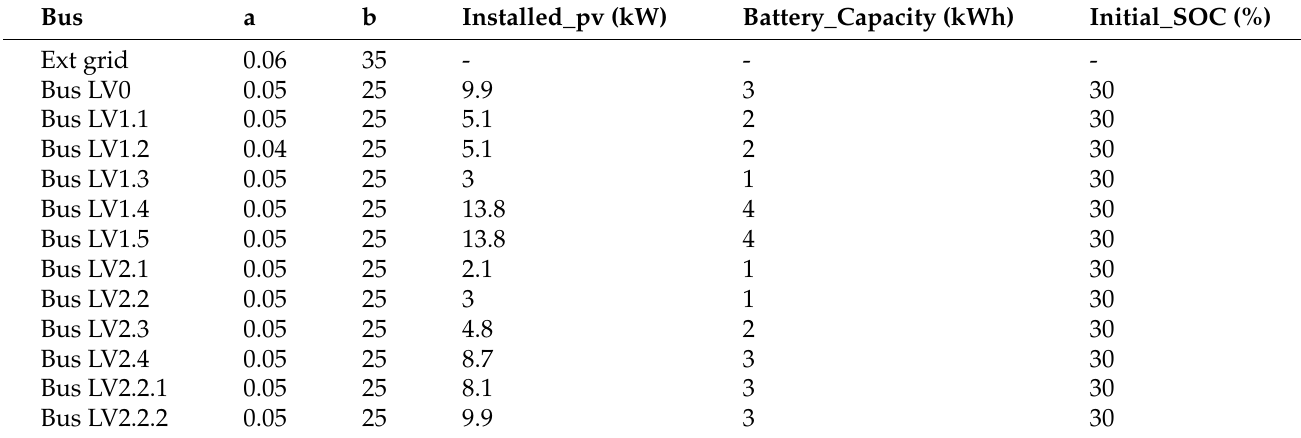
Table 1. Parameters for external grid and prosumer in selected 12-Bus